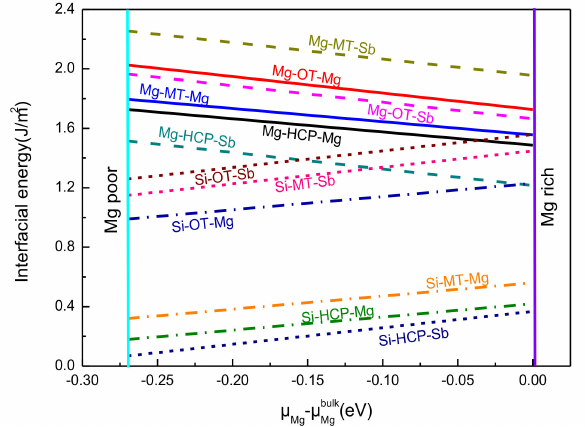
Figure 7. Interfacial energies of 12 interface systems as a function of the magnesium chemical potential.